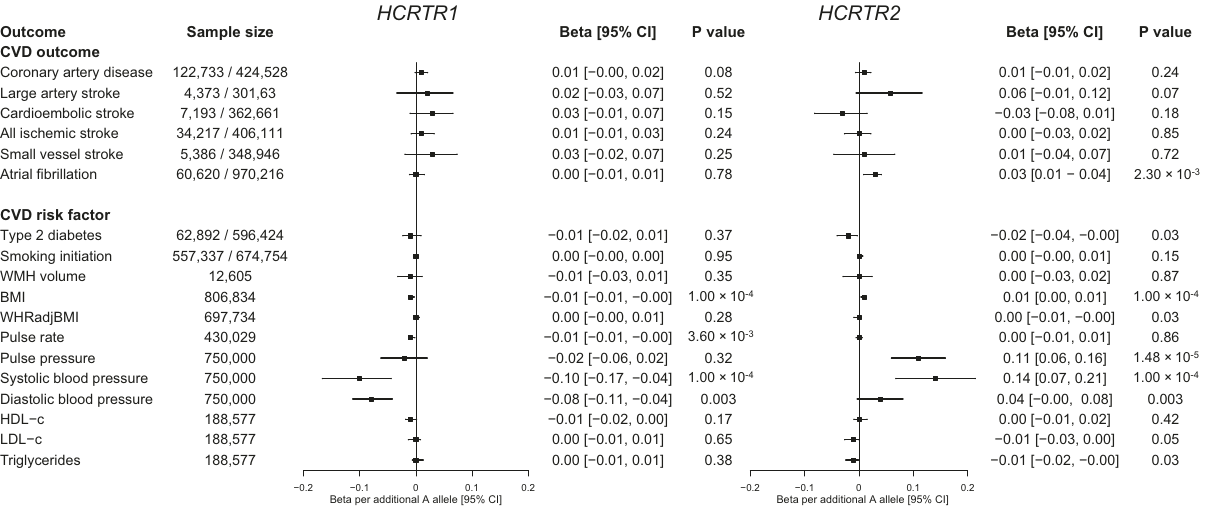
Fig. 6 Cardiovascular risk factor and disease associations of missense variants in HCRTR1 (rs2271933) and HCRTR2 (rs2653349), which encode targets of Suvorexant, an FDA-approved sleep medication with an unknown cardiovascular safety pro fi le. Sample size either re fl ects the total number of subjects (for continuous traits), or the number of cases and controls (for binary traits) that were included in each of the genome-wide association studies. All associations are oriented to the napping-increasing allele of the variants. Additional details regarding the included studies are provided in Supplementary Table 13 and Supplementary Data 13. Black boxes show Mendelian randaomization effect estimates and surrounding lines display 95% con fi dence intervals. BMI body-mass index, CI con fi dence interval, CVD cardiovascular disease, HDL high-density lipoprotein cholesterol, LDL low-density lipoprotein cholesterol, OR odds ratio, WMH white matter hyperintensities, WHR waist-to-hip